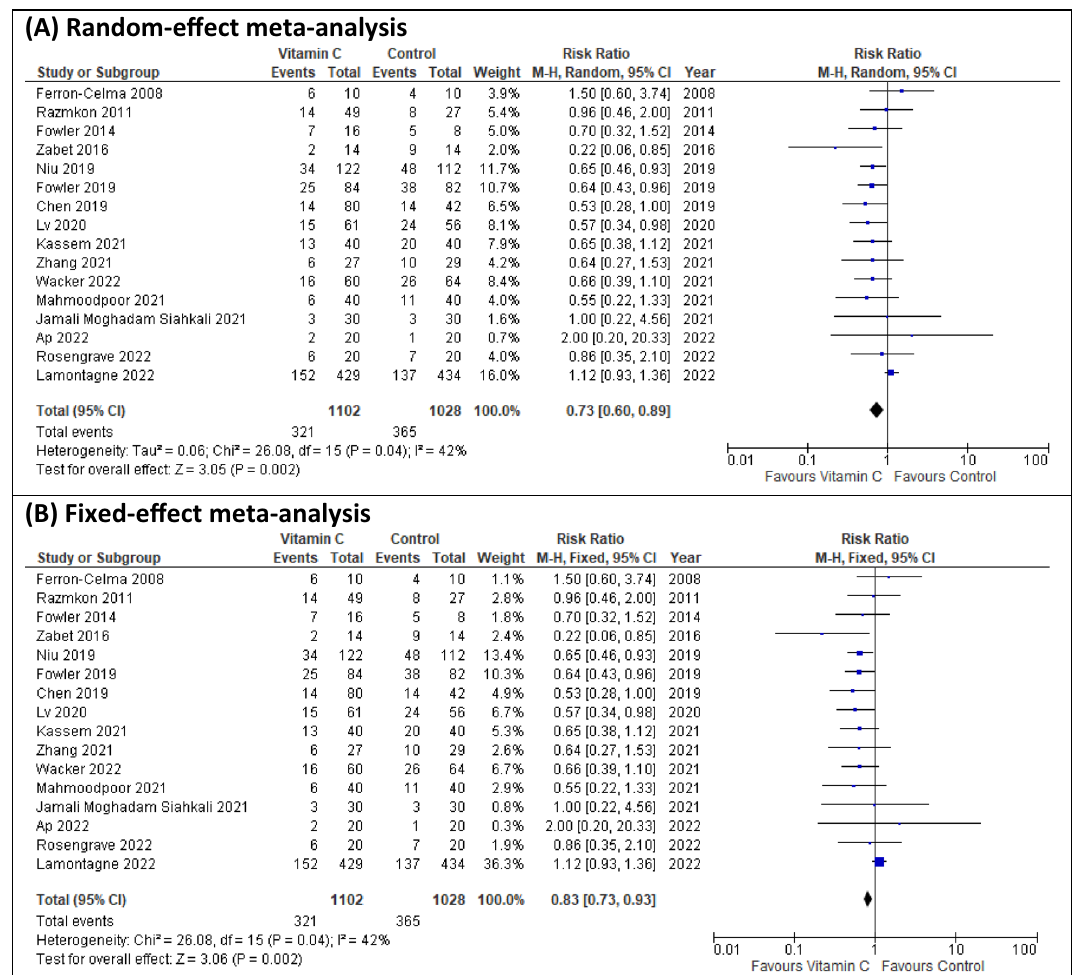
Fig. 2 Overall mortality. A Random‑effect meta‑analysis, and B sensitivity analysis with fixed‑effect